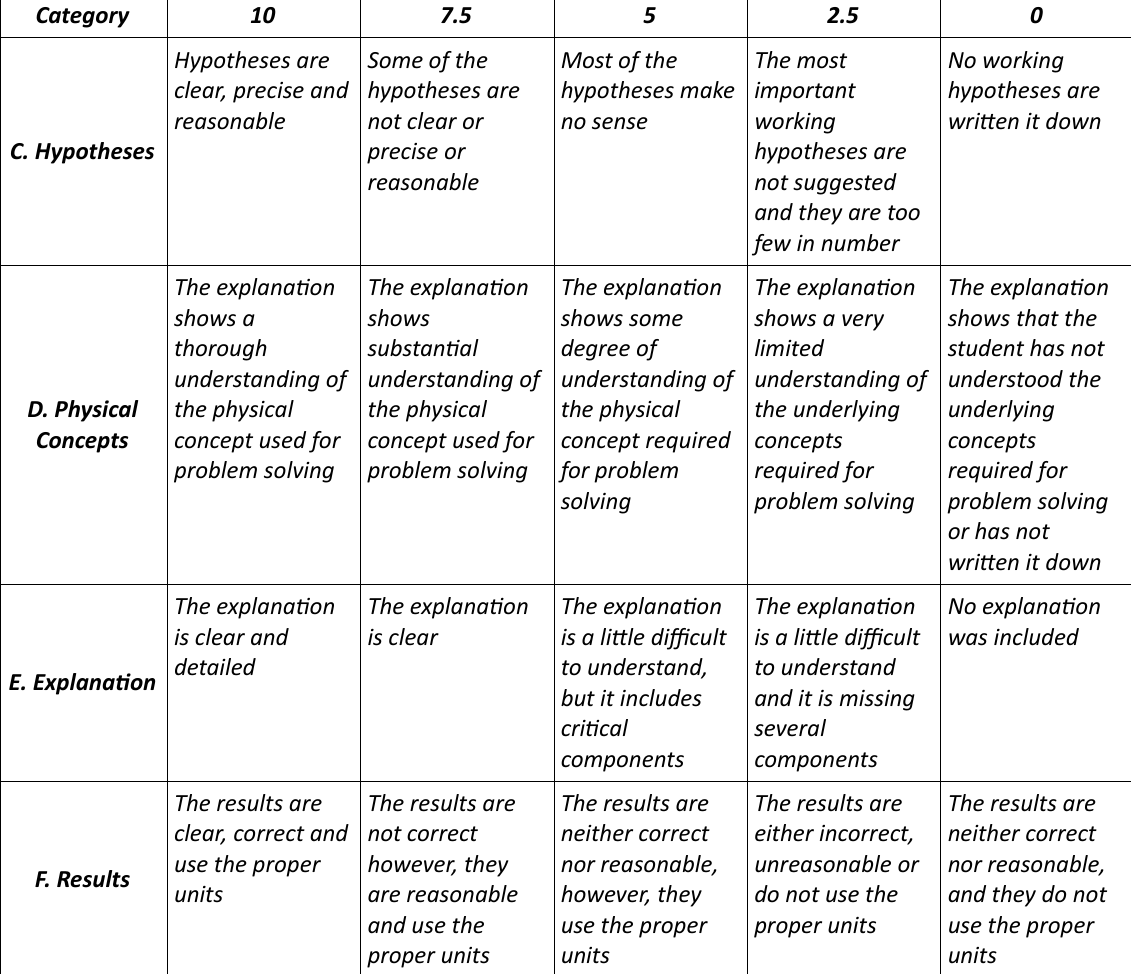
Table 1. Rubric and indicators for the assessment of partal and fnal exams in Fluid